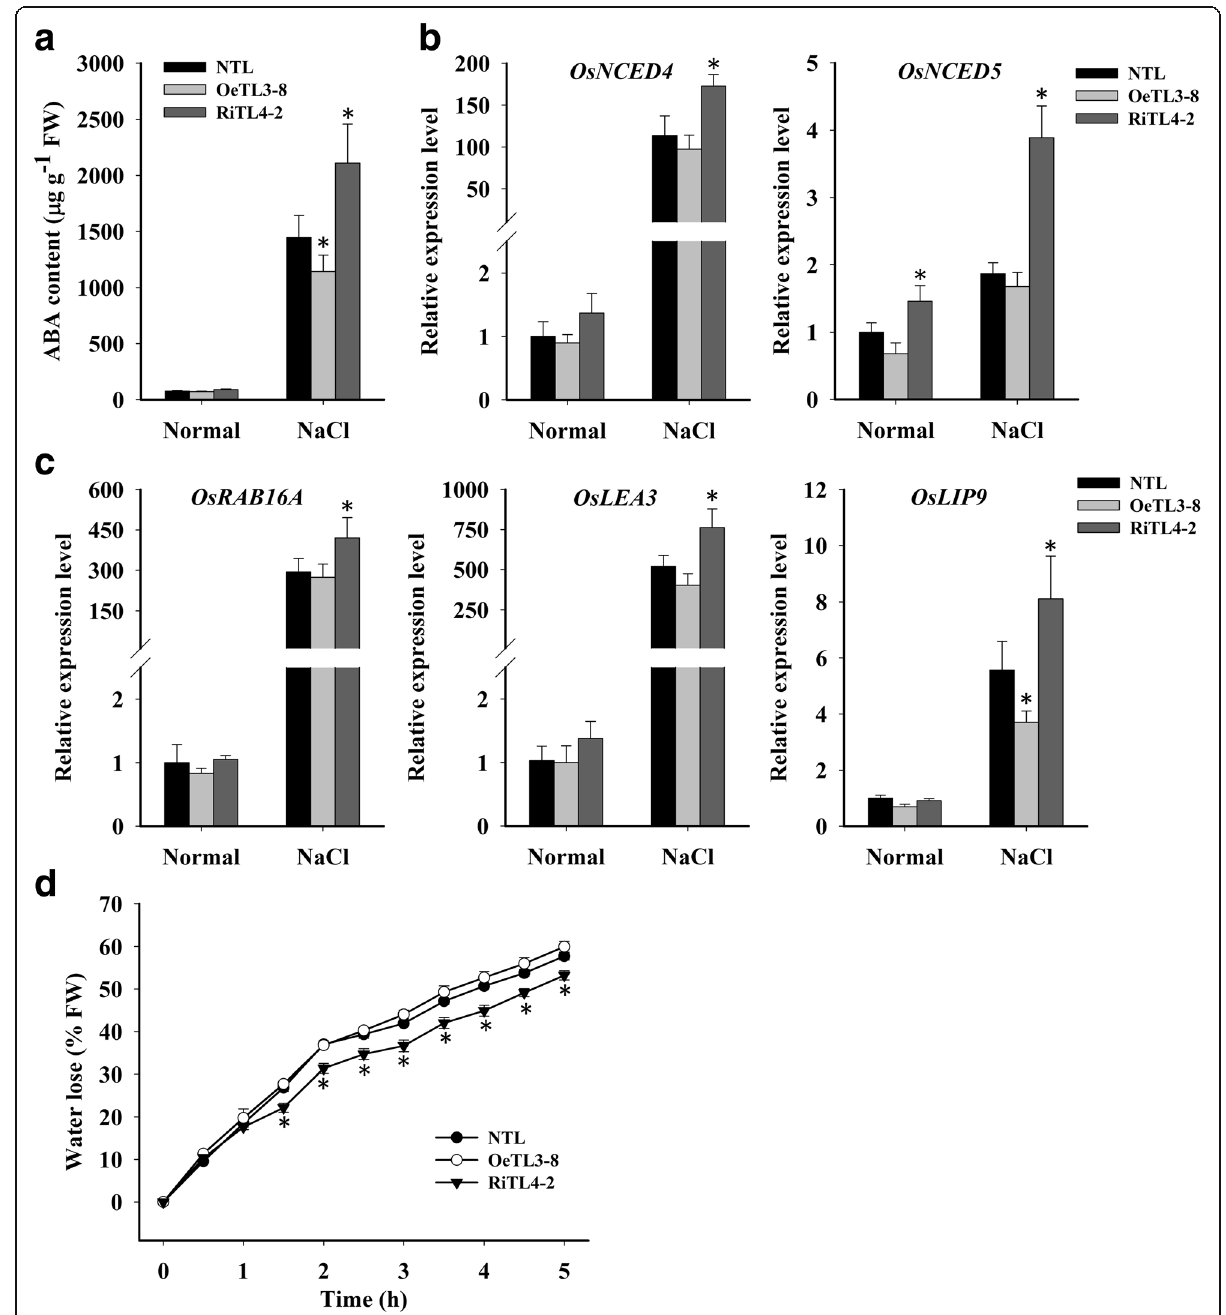
Fig. 5 OsRACK1A regulates ABA content and ABA-responsive genes under salt stress. a ABA content of various rice plants under normal and salt stress (150 mM NaCl). b Transcript level of ABA biosynthesis genes, OsNCED4 and OsNCED5 in various rice plants under normal and salt stress (150 mM NaCl for 24 h). c Transcript level of ABA- and stress-inducible genes in various rice plants under normal conditions and salt stress (150 mM NaCl for 24 h). d Water loss in various rice plants. Whole leaves of 14-d-old plants were cut off and used for the water loss assays. Sixty seedlings per genotype (twenty seedlings for each biological replicate) were used. Data shown are the means ± SE of three biological replicates. An asterisk indicates a significant difference ( P < 0.05) versus stressed